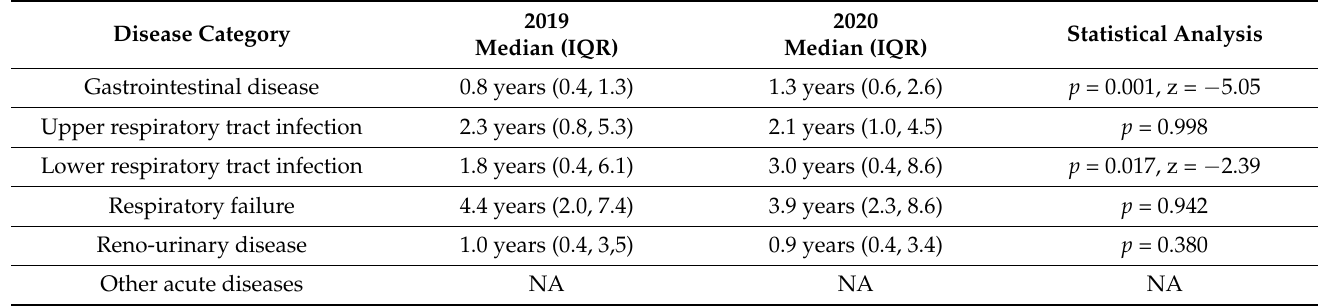
Table 3. Median age by pathology and period